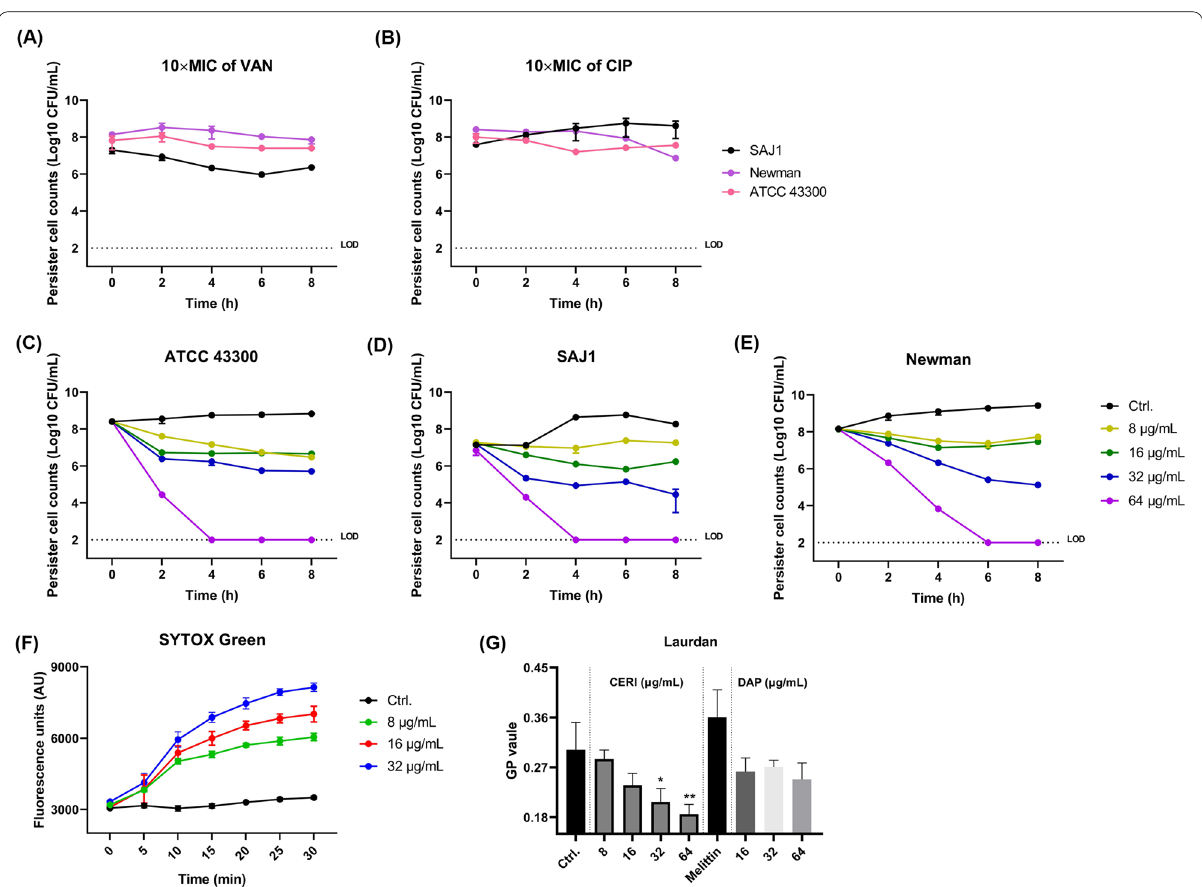
Fig. 3 The effects of CERI against S. aureus persisters. High resistance of S. aureus persisters against 10 MIC of vancomycin ( A ) and ciprofloxacin × ( B ). Time-killing activities of CERI against persisters of MRSA strain ATCC 43300 ( C ), VISA strain SAJ1 ( D ) and MSSA strain Newman ( E ) at concentrations of 16–128 μg/mL (1–8 MIC). Persister cell membrane permeability was determined by SYTOX Green staining after treatment with × various concentrations of CERI. (G) Detection of intracellular and extracellular ATP in S. aureus ATCC 43300 after treatment with 8–32 μg/mL of CERI for 30 min. The assays were repeated three times independently, and the results were presented as mean SD. Results were considered significant ± when * P < 0.05 and highly significant when ** P <